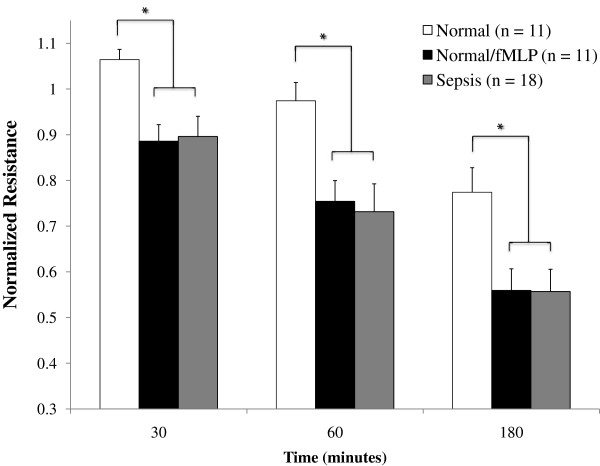
Septic and normal/N-formyl-l-methionyl-l-leucyl-l-phenylalanine neutrophils induce similar patterns of barrier dysfunction. Change in monolayer resistance at 30 minutes, 60 minutes, and 180 minutes. Groups were analyzed using two-way analysis of variance with Holm–Sidak post-hoc analysis. Values presented as mean ± standard error of the mean. Both normal/N-formyl-l-methionyl-l-leucyl-l-phenylalanine (fMLP) and septic patient neutrophils caused a greater change in barrier function than untreated normal neutrophils; however, there was no difference between normal/fMLP and septic patient neutrophils at any time point. *P <0.05 vs. normal.